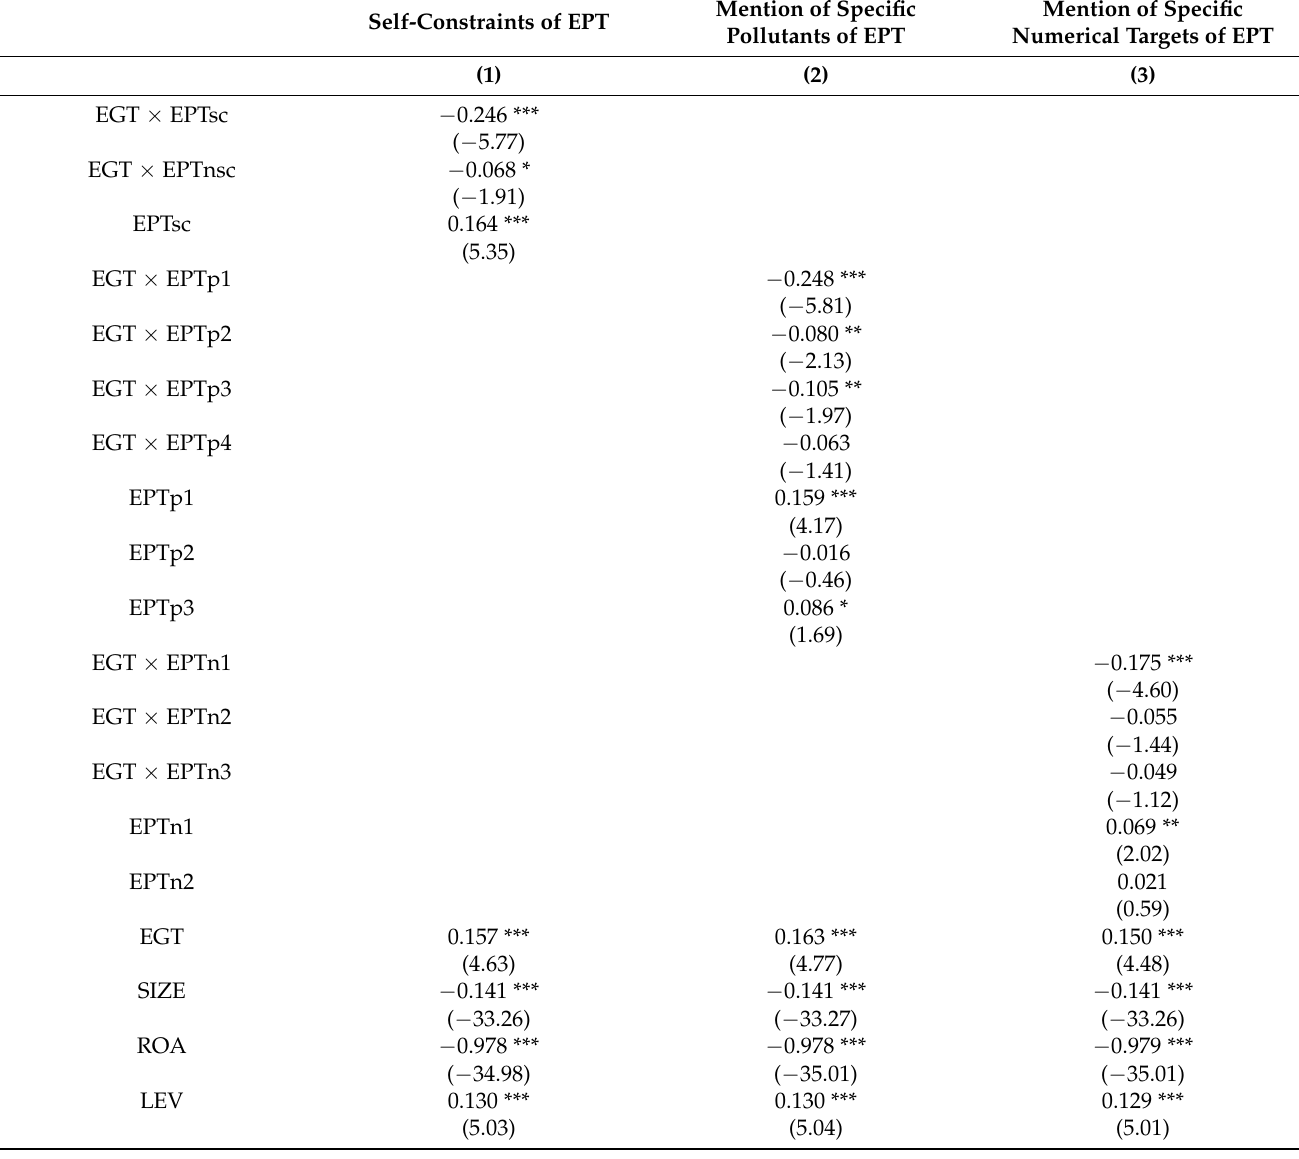
Table 9. Reverse the positive trend of EGT and Emission. Self-Constraints of